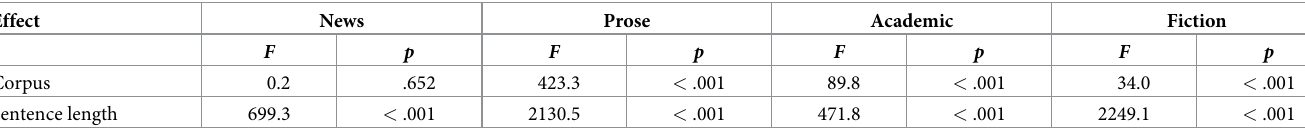
Table 4. ANOVA results for the by-genre separate